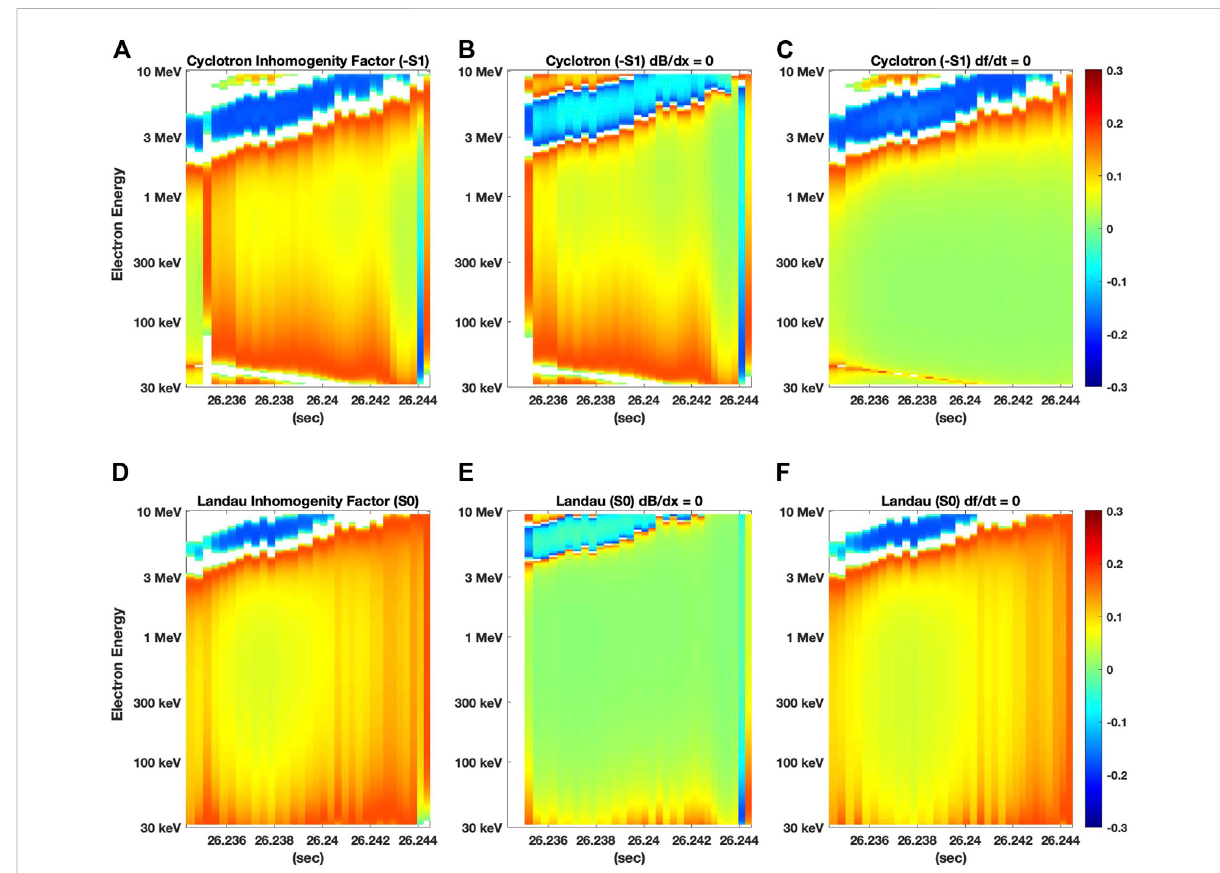
FIGURE 9 The nonlinear inhomogeneity factors for cyclotron ( − S1) and Landau (S0) resonance are shown in the upper and lower panels respectively. S factors have been calculated wave cycle by cycle for a range of resonant electron energies for the subpacket indicated in Figure 4. Each value of S1andS0has beenmultipliedbythetrapping potential invelocityphase space,F(|S|). White regions oneachpanel indicatethat |S| > 1where F(|S|)= 0 and trapping does not take place (see text). (A,D) present the full calculations for S1 and S0 including both df/dt and dB/dx terms. For panels (B,E) , dB/dx has been set to zero. In (C,F) , df/dt =